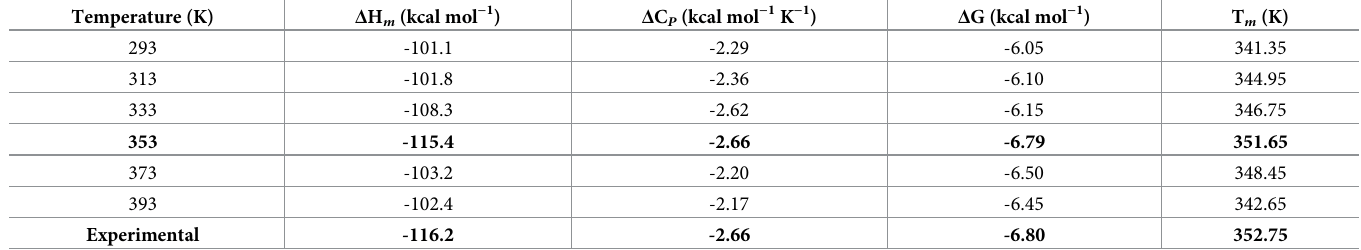
Table 3. Predicted and experimental values of thermodynamic and thermal parameters of ensembles of SazCA at different temperatures. The thermal and thermody- namic parameters of crystal structure (experimental) of SazCA are also shown for comparison. Temperature